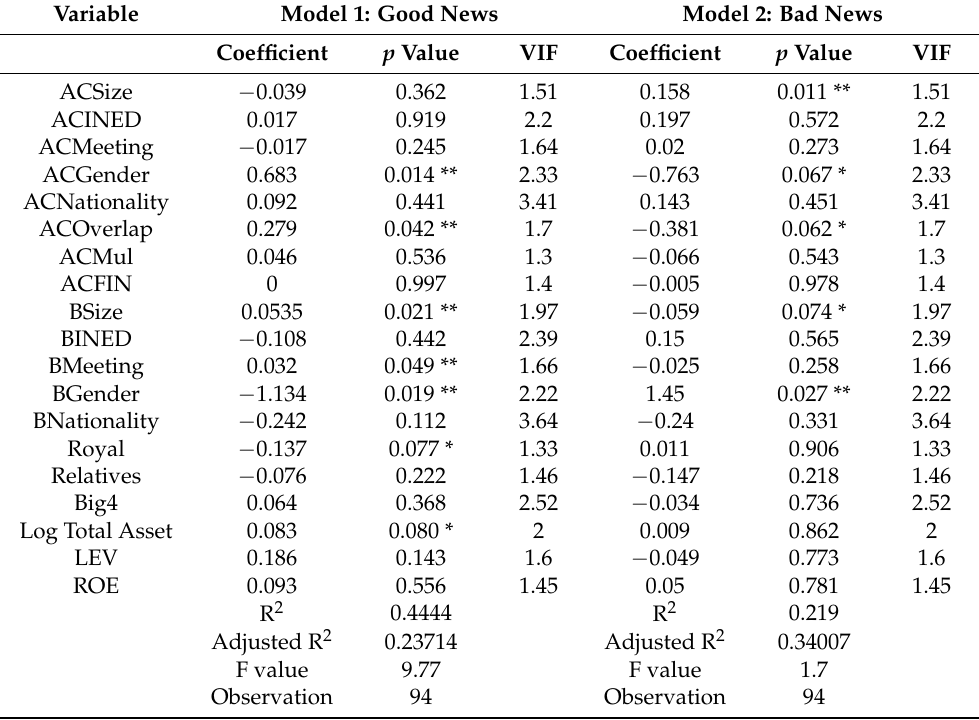
Table 2. Multiple Regression